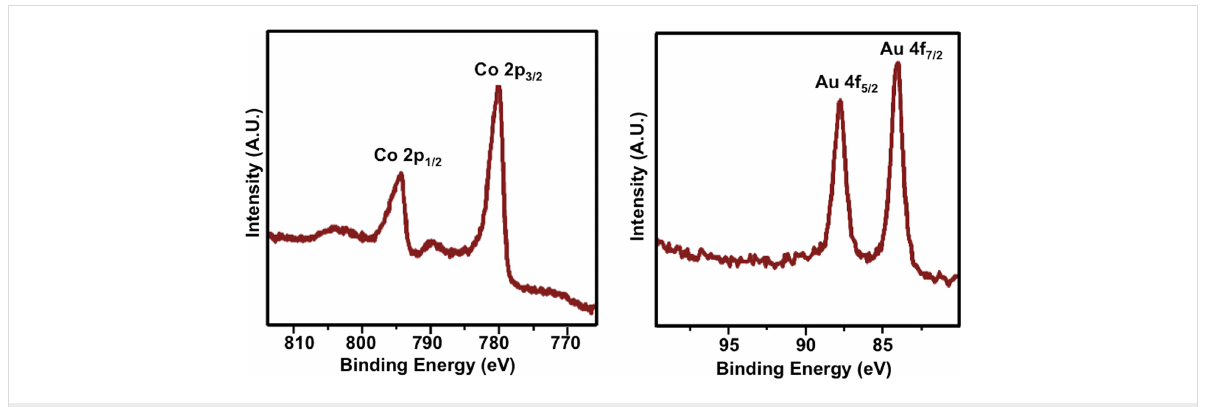
Figure 5: XPS spectra of the Au@Co nanochains.